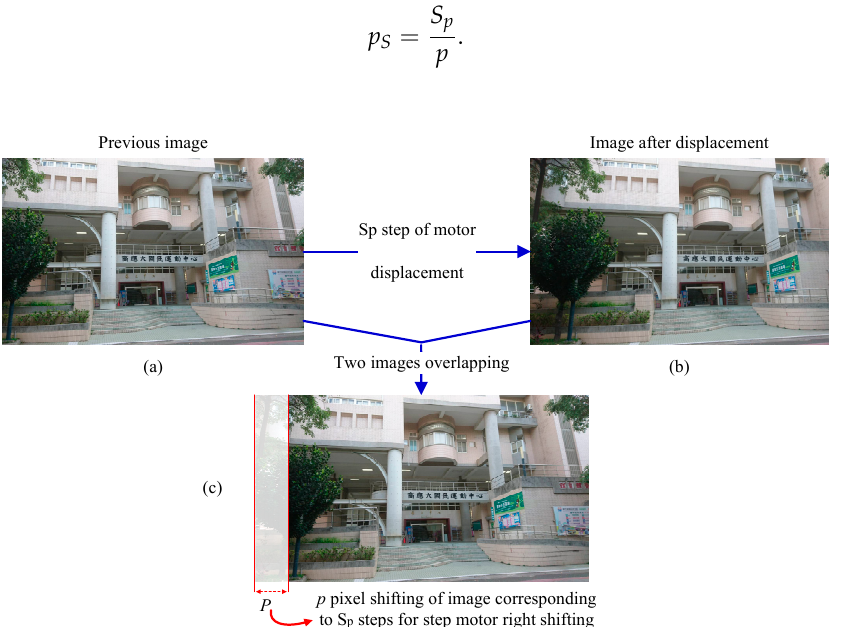
Figure 5. Schematic diagram of the relationship between the step angle and image.